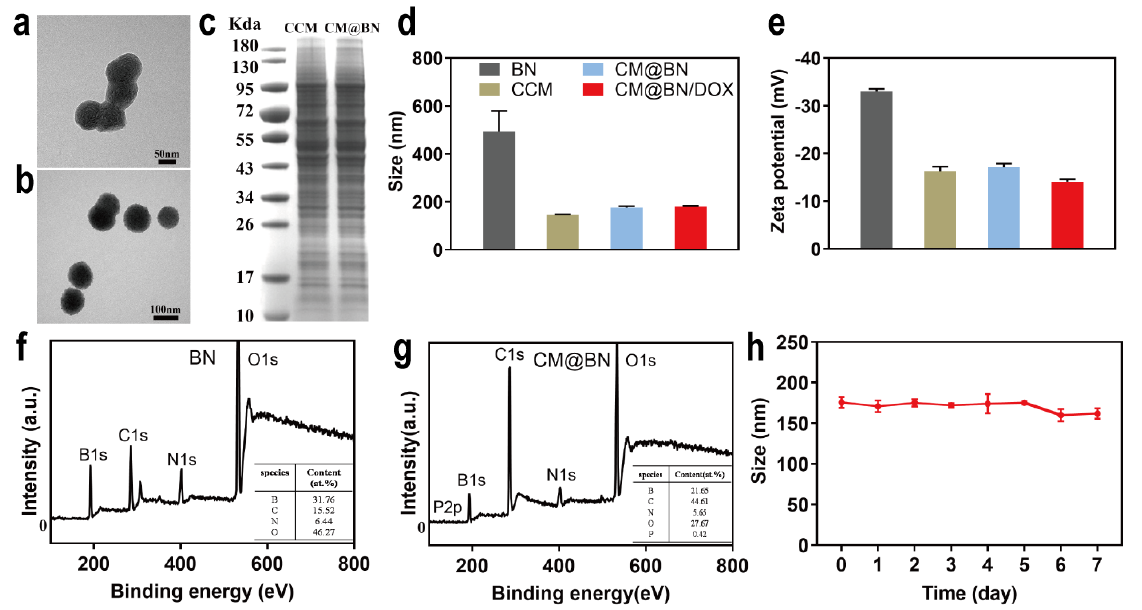
Figure 2. Characterization of CM@BN/DOX. ( a ) TEM image of boron nitride (BN). ( b ) TEM image of CM@BN. ( c ) The protein profiles of the BV2 cell membrane fragments and CM@BN. ( d ) Hydro- dynamic size of BN, CCM, CM@BN, and CM@BN/DOX. ( e ) Zeta potentials of BN, CCM, CM@BN, and CM@BN/DOX. ( f ) XPS spectrum of BN. ( g ) XPS spectrum of CM@BN. ( h ) Stability of